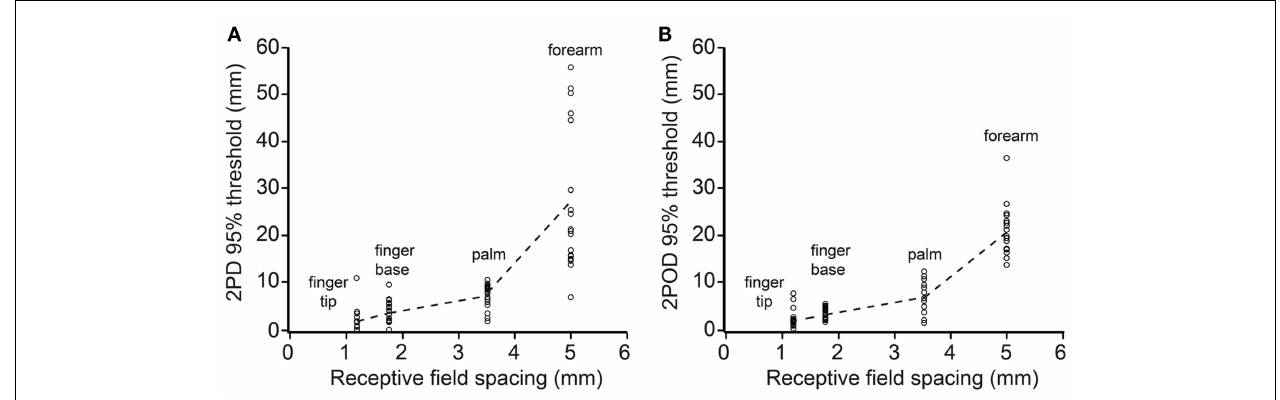
2000): fingertip (1.20mm), finger base (1.77mm), palm (3.53mm), forearm (5.00mm). Data points show individual participant performance; dashed lines connect group means.